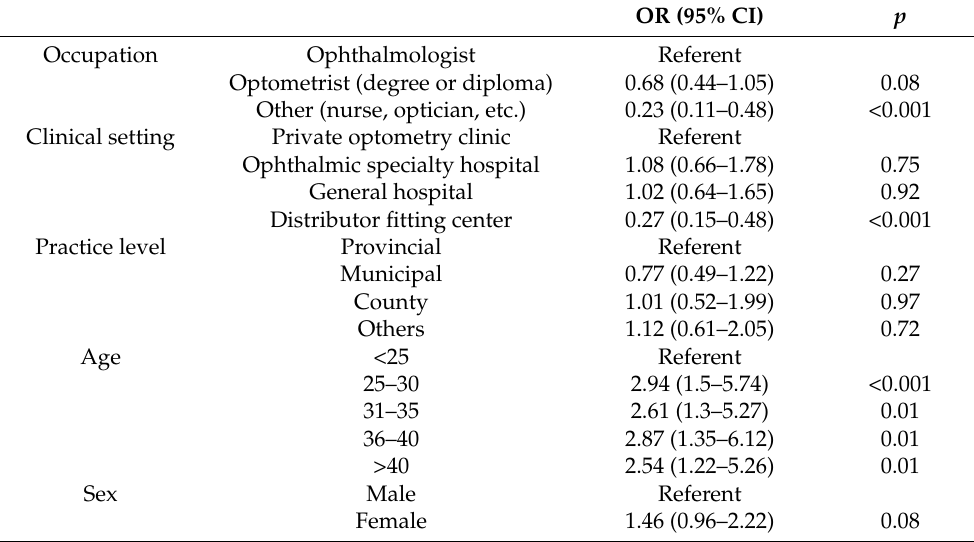
Table 3. The results of logistic regression models of respondents’ demographics on overall proper antibiotic eye drop